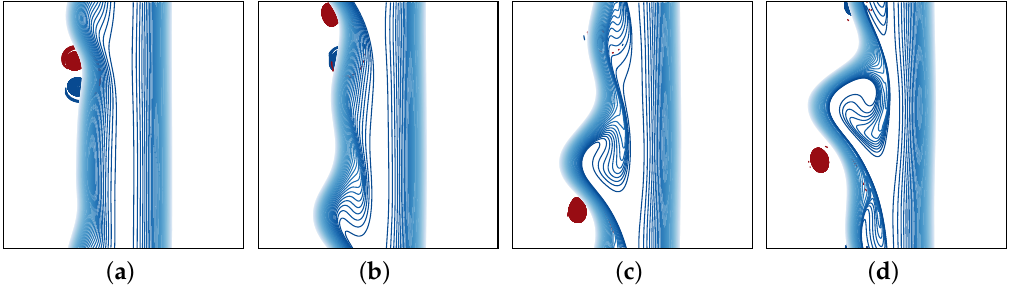
Figure 18. Case 6.5: effect of a very wide filament, a = 1.25, which is linearly stable in isolation. Here b ∗ m is increased in proportion to a to keep Λ the same as in the default case 1. Top view of the flow showing contours of buoyancy and PV at t = 10, 17, 25 and 36.5 from ( a ) to ( d